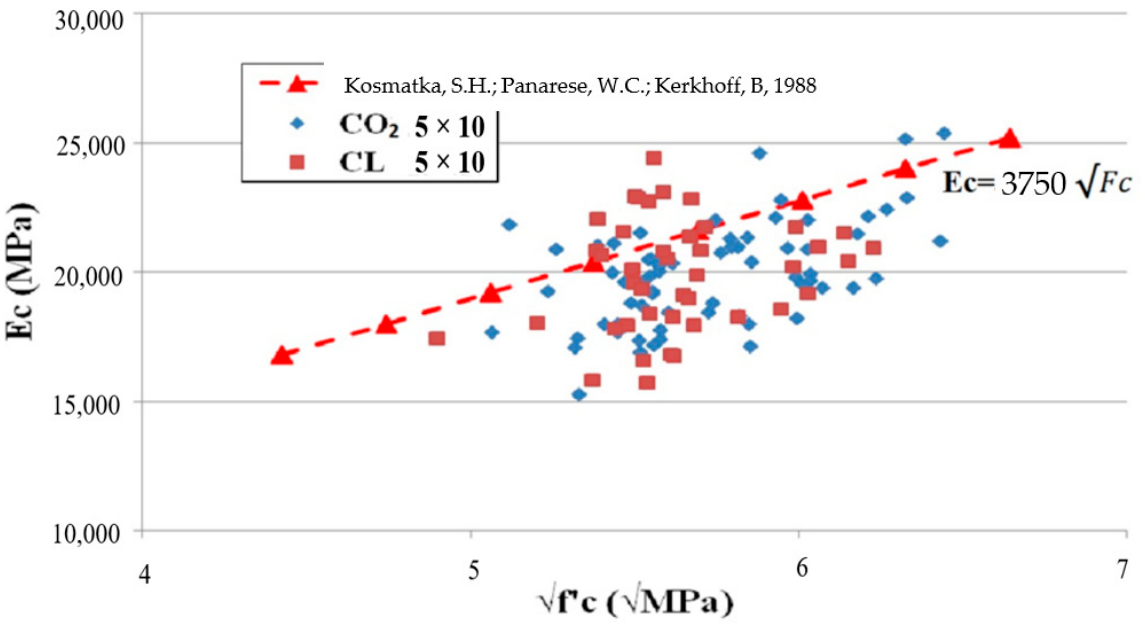
Figure 7. Relationship between elastic modulus and square root of strength obtained from 5 × 10 cm cylinders. Partialy adapted from Ref.